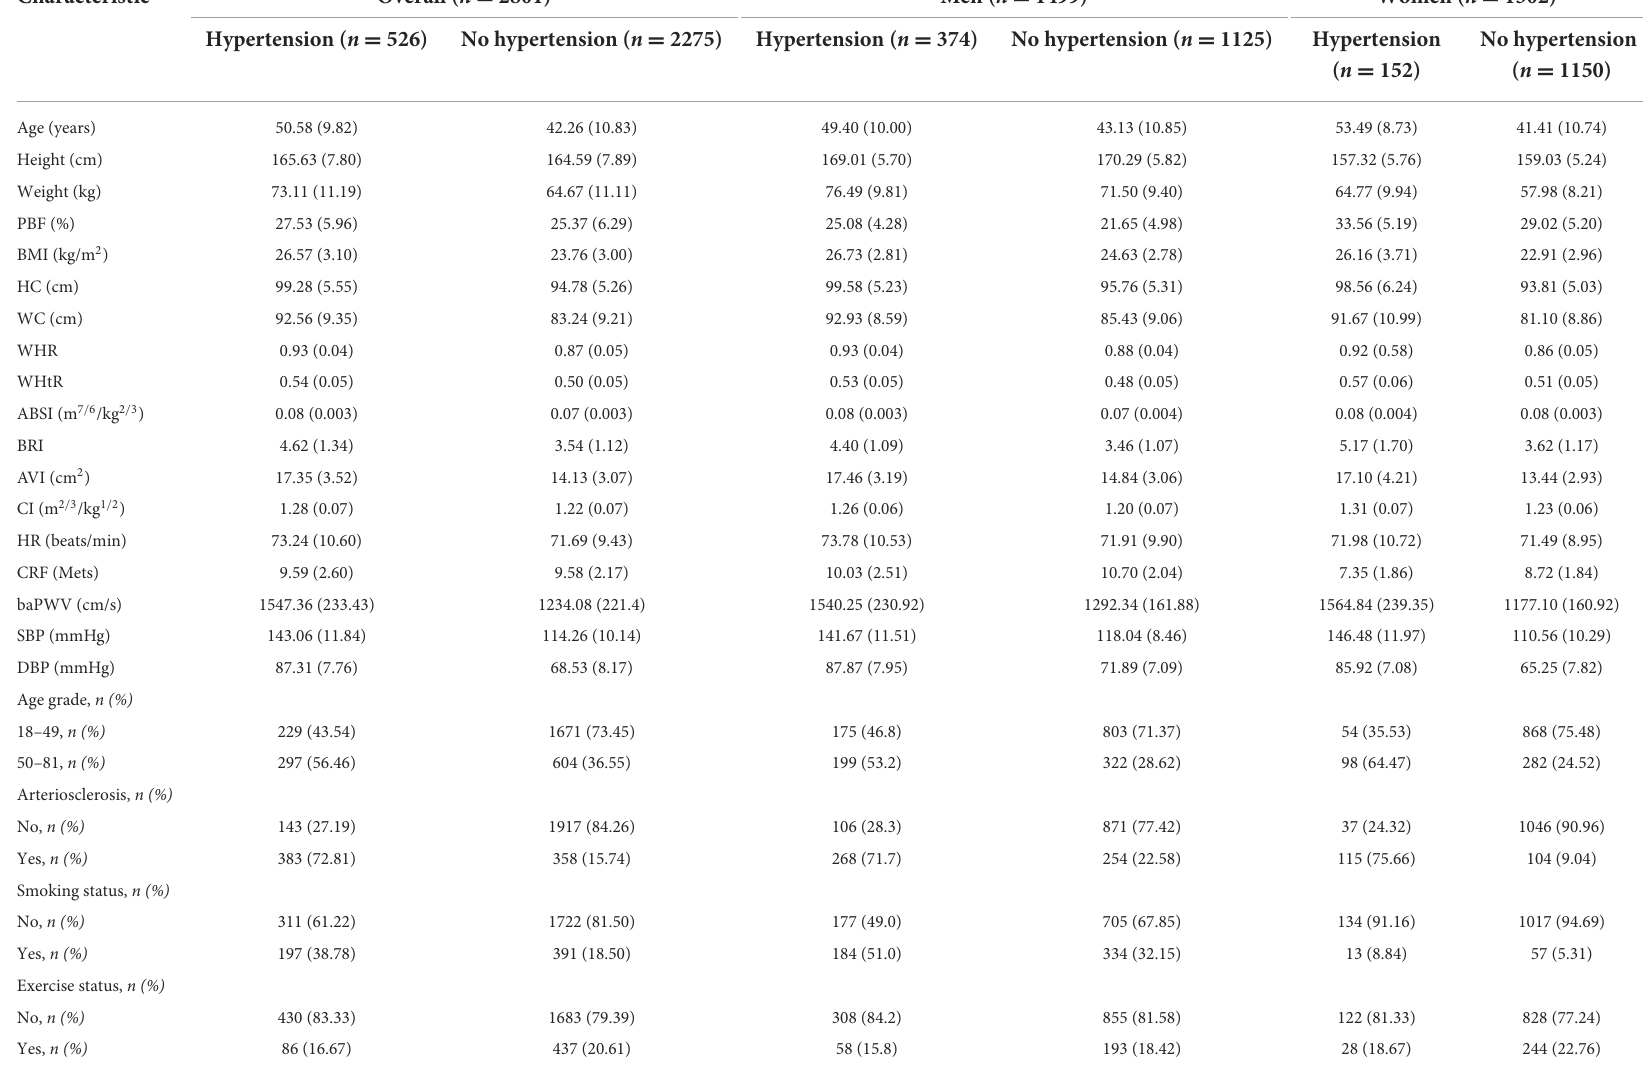
TABLE 2 Participants characteristics at